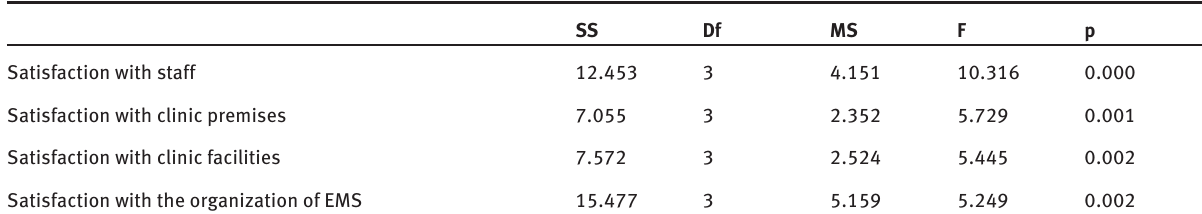
Table 3: Variance analysis – Impact of the effectiveness of the EMS organizational model on patient satisfaction (legend: SS – sum of squares, Df – degrees of freedom, MS – mean square)